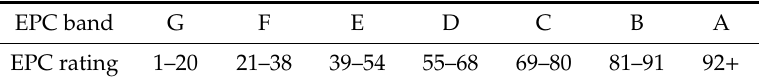
Table 1. EPC ratings mapped to EPC